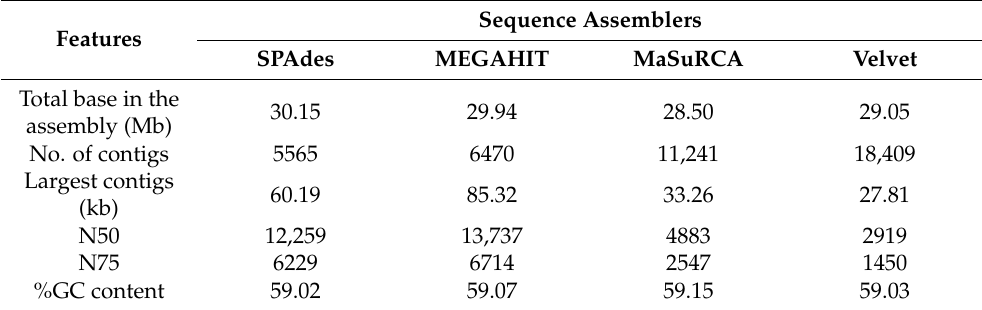
Table 1. Summary of the de novo assembly parameters after assembling sequence reads of L. orientalis isolate PCM2 using four